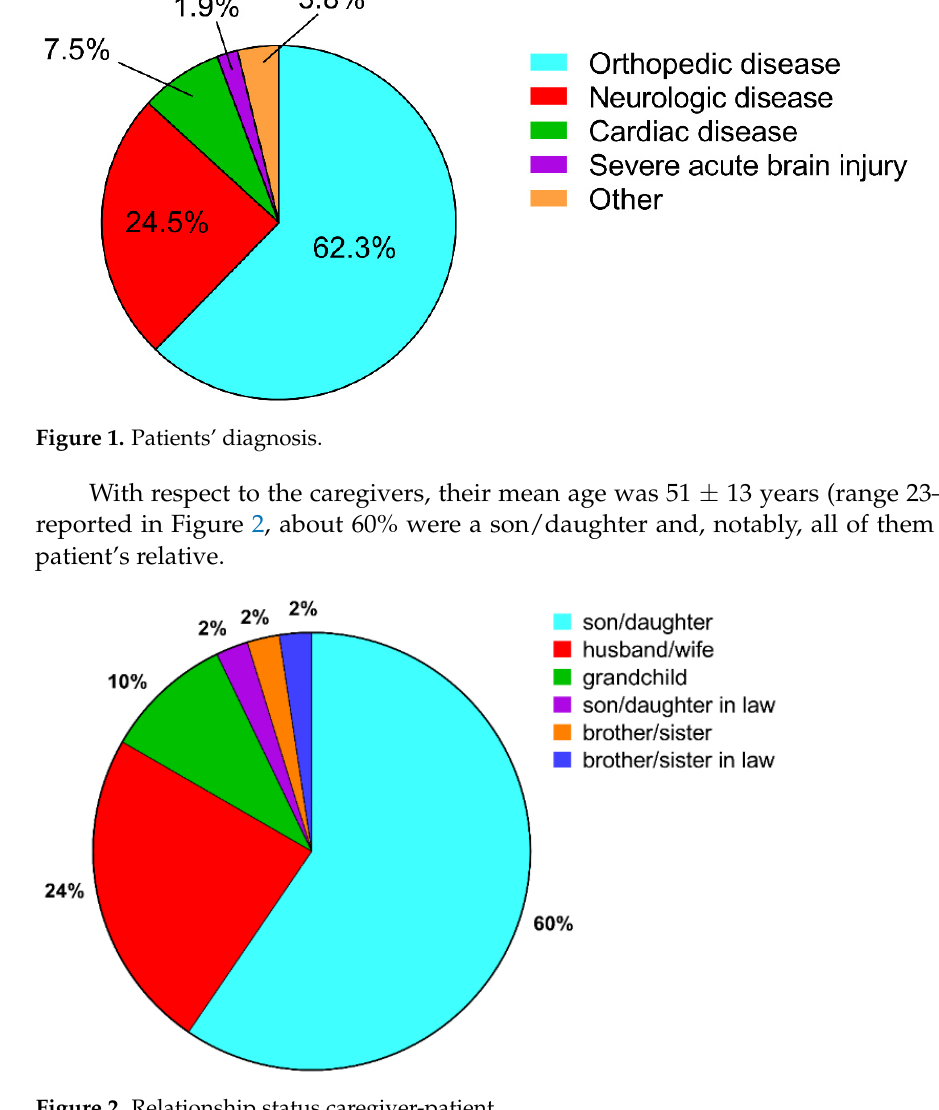
Figure 3. Beck Anxiety Inventory scores and Beck Depression Inventory scores in patients and caregivers. The asterisks indicate a statistically significant difference (** p < 0.01, according to the Mann – Whitney U test). Concerning the SF-36 questionnaire results, the eight items produced by the responses were compared between patients, caregivers, and normative data from an Italian population (n = 2031), according to Apolone et al. [15], and reported in Figure 4.